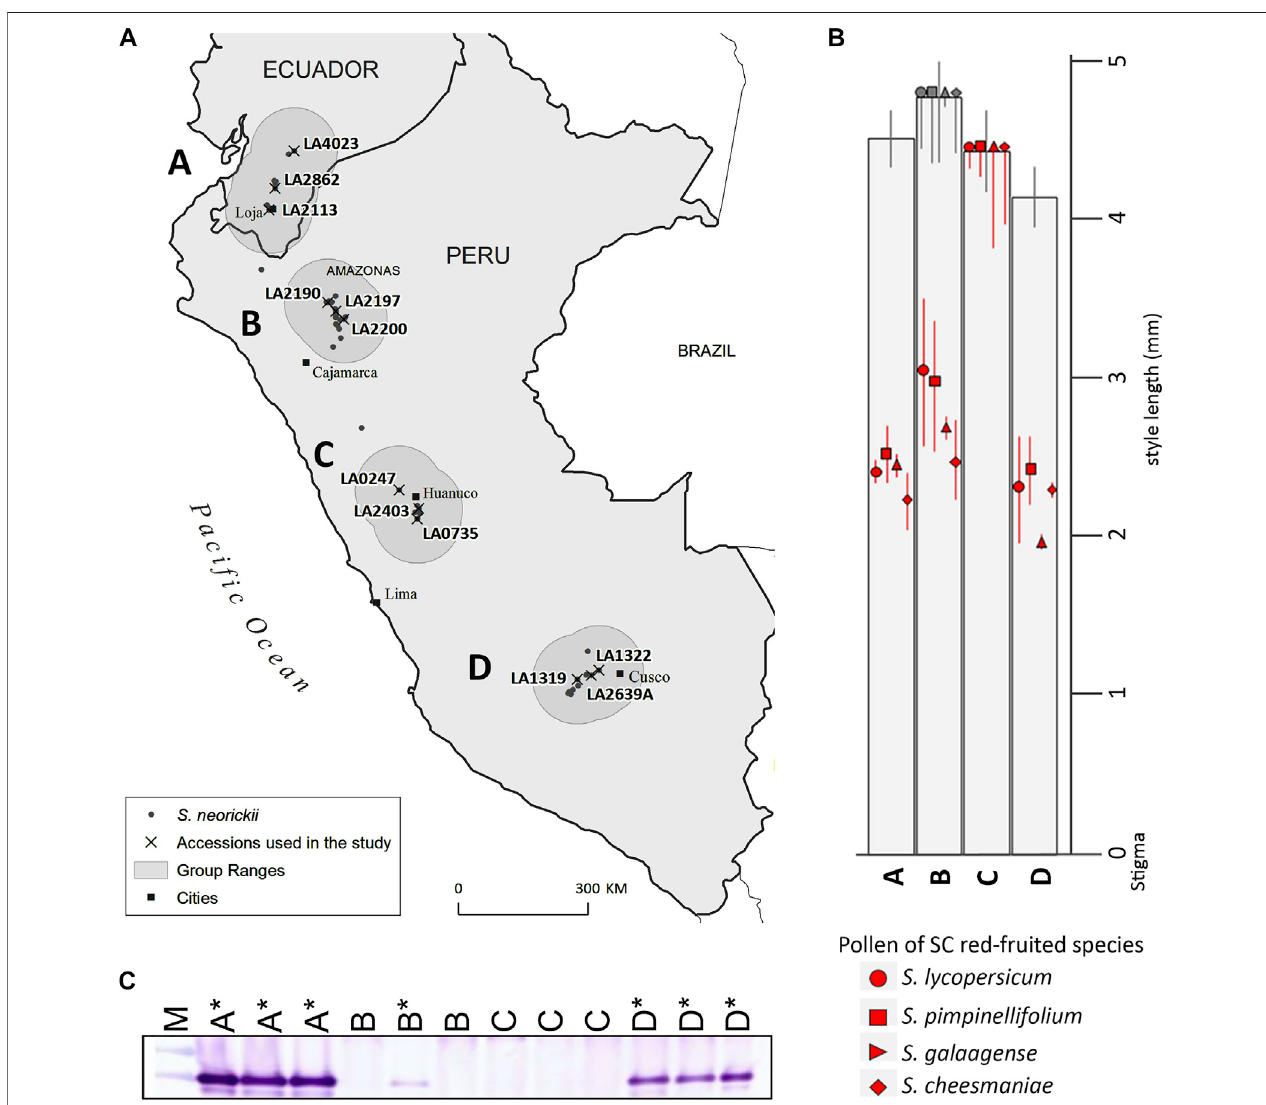
FIGURE 2 | Distribution, IRBs and S-RNase expression in S. neorickii geographic groups A-D . (A) Accessions used in this study are grouped according to geographical location (north to south) and range (shaded regions) within the species distribution. (B) Red/orange species pollen tube lengths 48 h post-pollination in S. neorickii stylesareshown inmillimetersand include the average length ofthemajority ofpollen tubes (species symbols) and standard deviation(bars).Pollen tubes grew to ovaries in some individuals of geographic group B (gray symbols), but not in others (red symbols). (C) Immunoblot of stylar extracts using the tSRNC2 antibody raised to the conserved C2 region of S-RNases. Sample order is M, molecular weight marker; LA4023 (group A); LA2862 (A); LA2113 (A); LA2190 (B); LA2197 (B); LA2200 (B); LA0247 (C); LA0247 (C); LA0735 (C); LA1322 (D); LA2639A (D); LA1319 (D). * (cid:1) accessions/individuals in which pollen tubes from red-fruited species are rejected in styles (presence of IRBs). The expression of S-RNase in Group B LA2197 was con fi rmed in a separate blot using a greater volume of extract (not